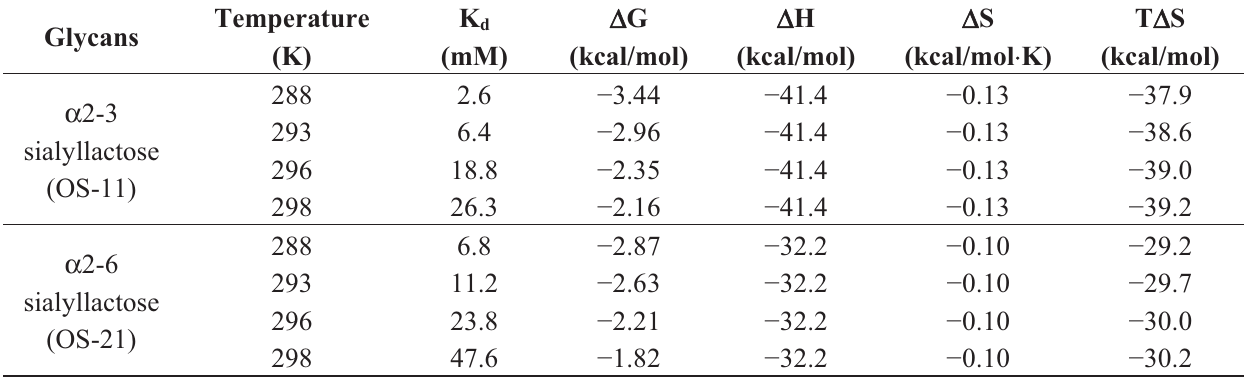
Table 3. Equilibrium dissociation constants of A/Mem71with α 2-3-sialyllactose (OS-11) and α 2-6-sialyllactose (OS-21) between 288K and 298K, and the corresponding changes in thermodynamic functions as a result of complex formation as deduced from the temperature dependence of the dissociation